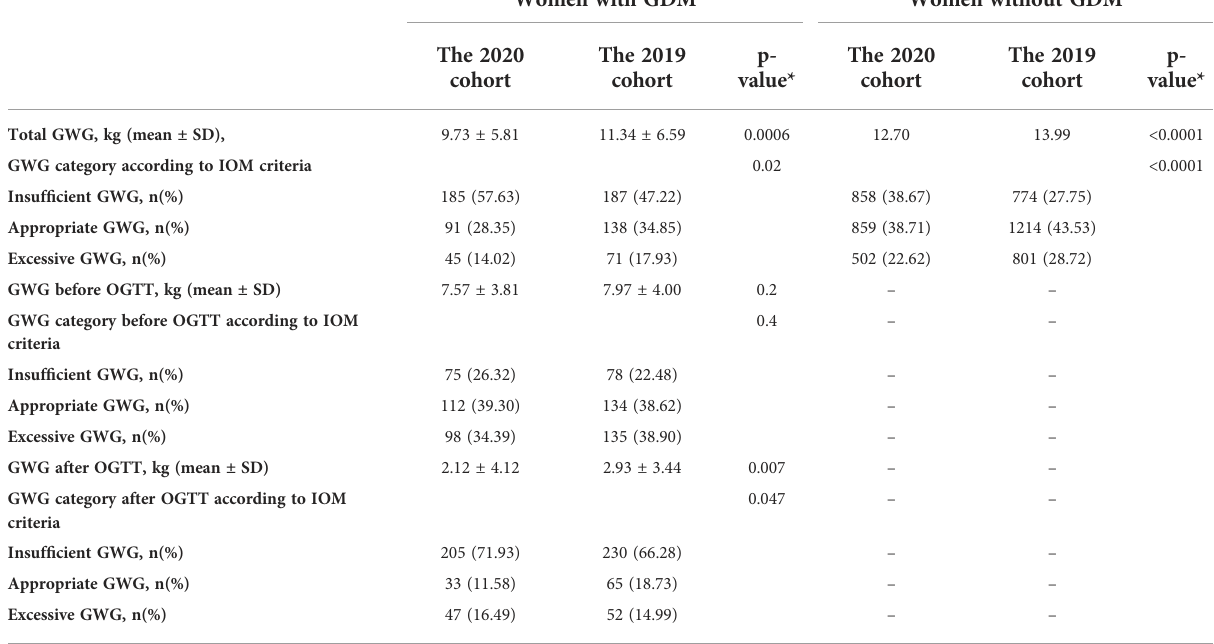
TABLE 2 Changes in body weight during pregnancy in 2019 and 2020 cohort.